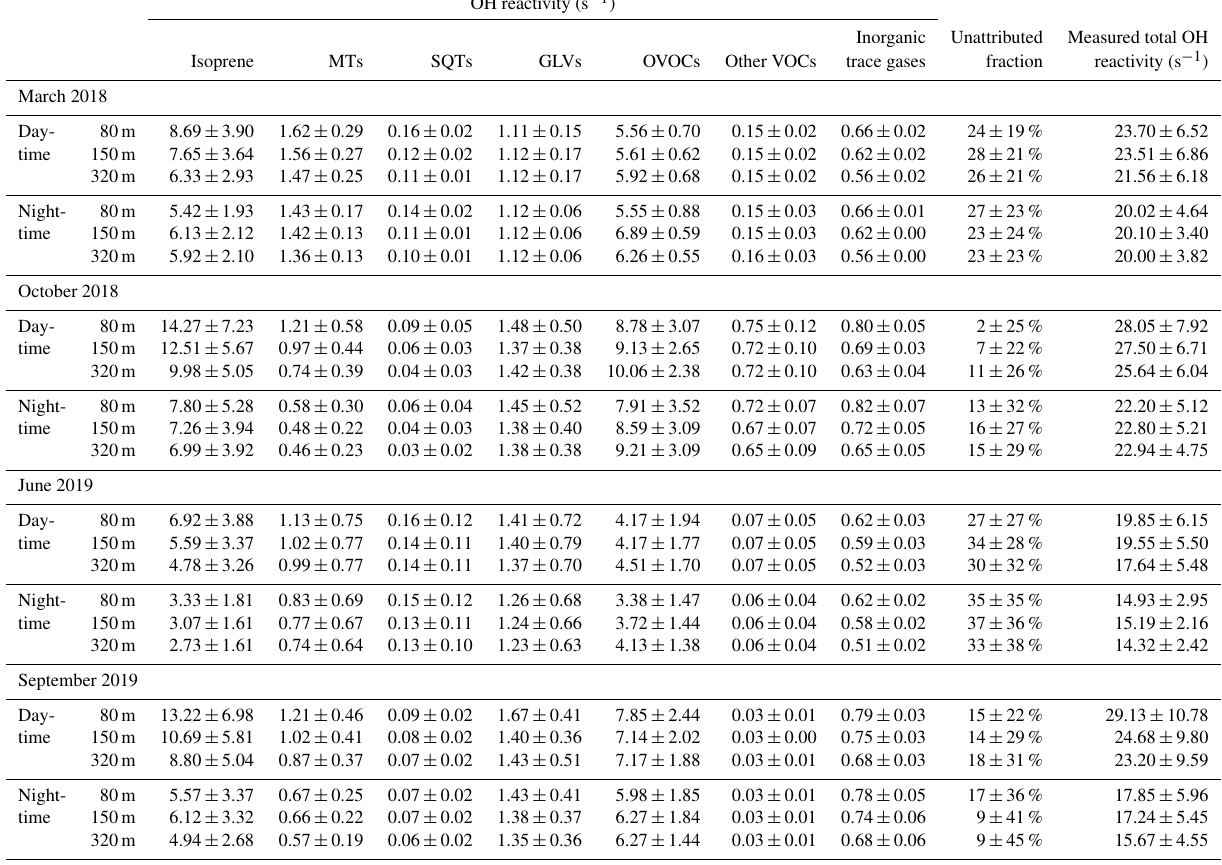
Table 1. Overview of average measured total and speciated OH reactivity and unattributed (missing) fraction of total OH reactivity by season and measurement height, separated by day and night. Values shown are averages ± standard deviations. The chemical species attributed to each group are listed in Table S1. For an explanation of unattributed or speciated OH reactivity, refer to Sect. 2.5. MTs: monoterpenes; SQTs: sesquiterpenes; GLVs: green leaf volatiles; OVOCs: oxygenated VOCs. OH reactivity (s − 1 ) Inorganic Unattributed Measured total OH